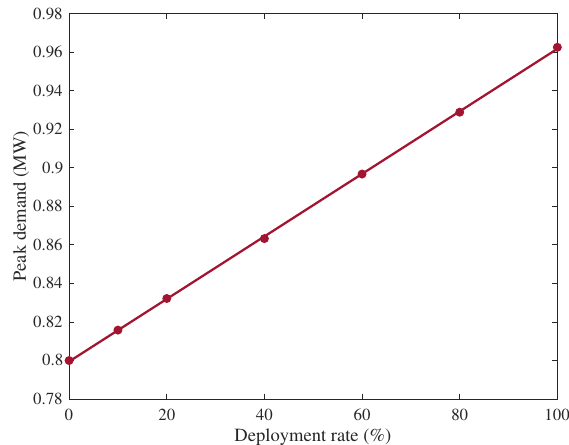
Figure 12. Feeder’s peak demand with different EVs deployment